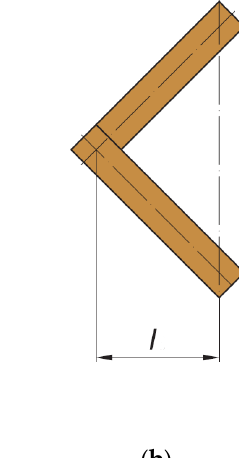
Figure 5. Type and dimensions of the tested samples. Reprinted with permission from Ref. [11].